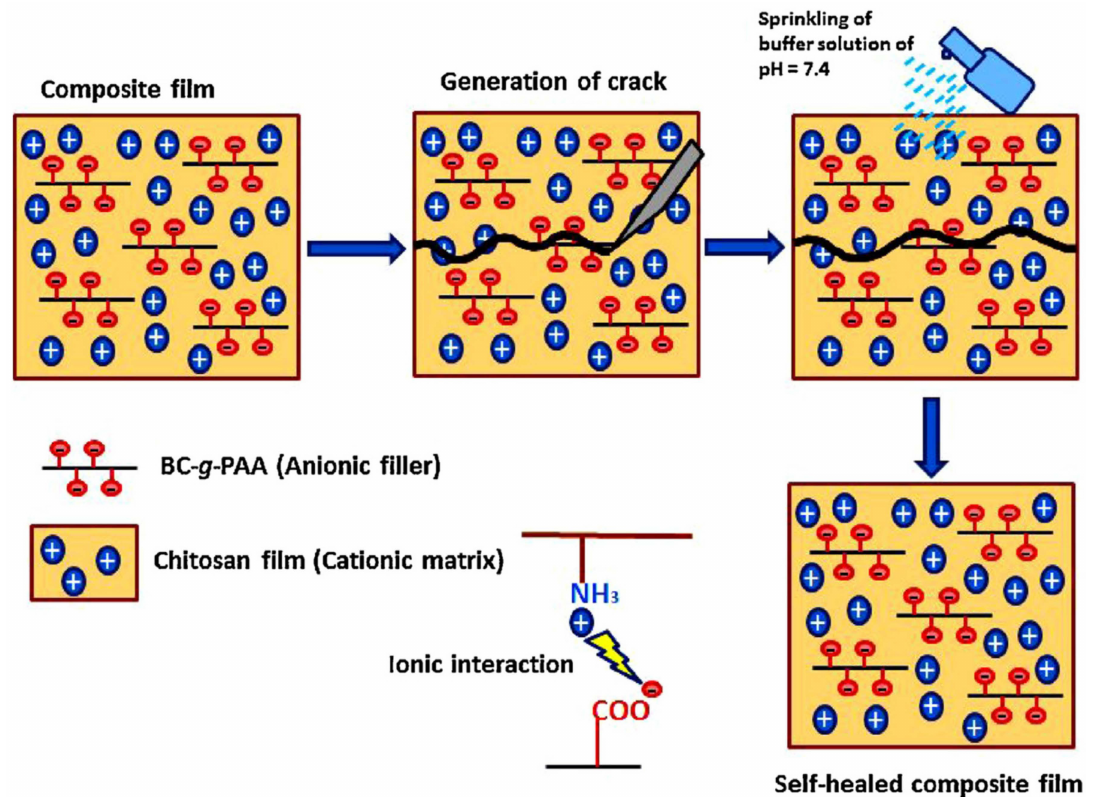
Figure 3. The simple schematic shows the self-healing mechanism of cationic chitosan matrix assisted by anionic filler (Poly(acrylic acid) grafted bacterial cellulose). (Reproduced with permission from [43] Copyright 2017, Elsevier).